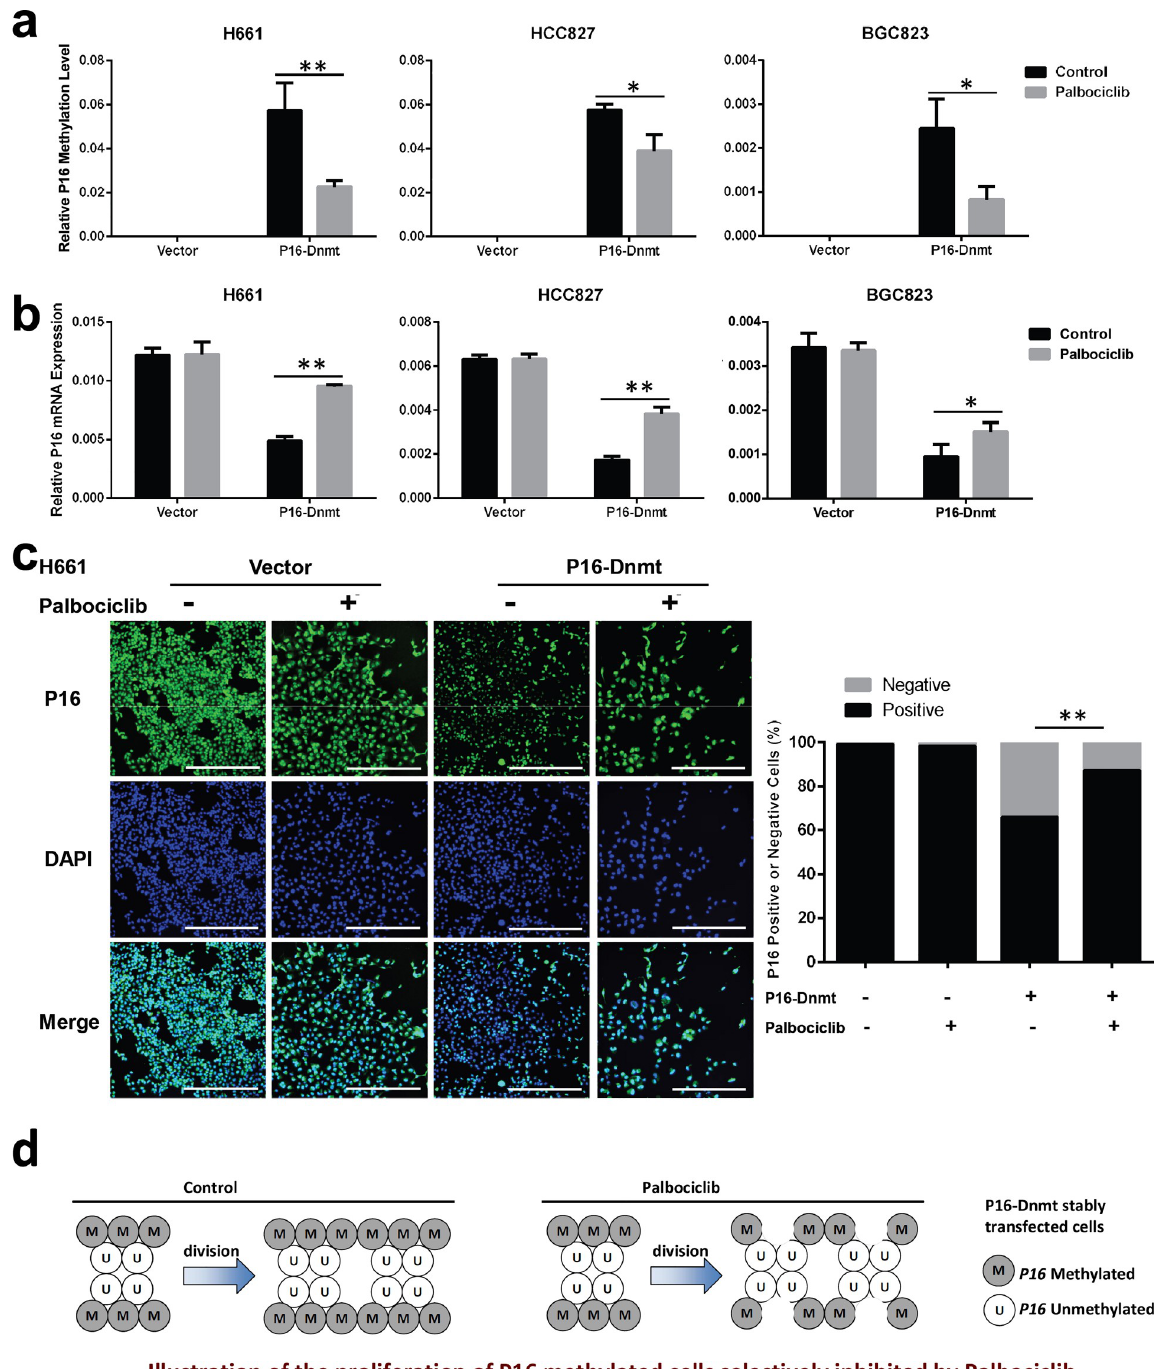
Fig 3. Selective inhibition of the proliferation of P16 -methylated cancer cells by palbociclib in vitro . After palbociclib treatment (H661 and BGC823 cells: 10 μ M; HCC827 cells: 7 μ M) for 48 hrs, cells were harvested at 70–80% confluence. ( a and b ) Effect of palbociclib treatment on the levels of P16 -methylated alleles and P16 mRNA in cell lines stably transfected with P16-Dnmt, as assessed by MSP and qRT-PCR assays, respectively. The data are presented as the means ± SDs. ( c ) The results of immunofluorescence and confocal microscopy analyses to directly detect changes in the subpopulation of cells staining positive for P16 protein within the H661 cell line stably transfected with P16-Dnmt. ( d ) Illustration of the proliferation of P16 methylated cells selectively inhibited by palbociclib treatment. Scale bar, 400 μ m. Student’s t-test, � p < 0.05, �� p <